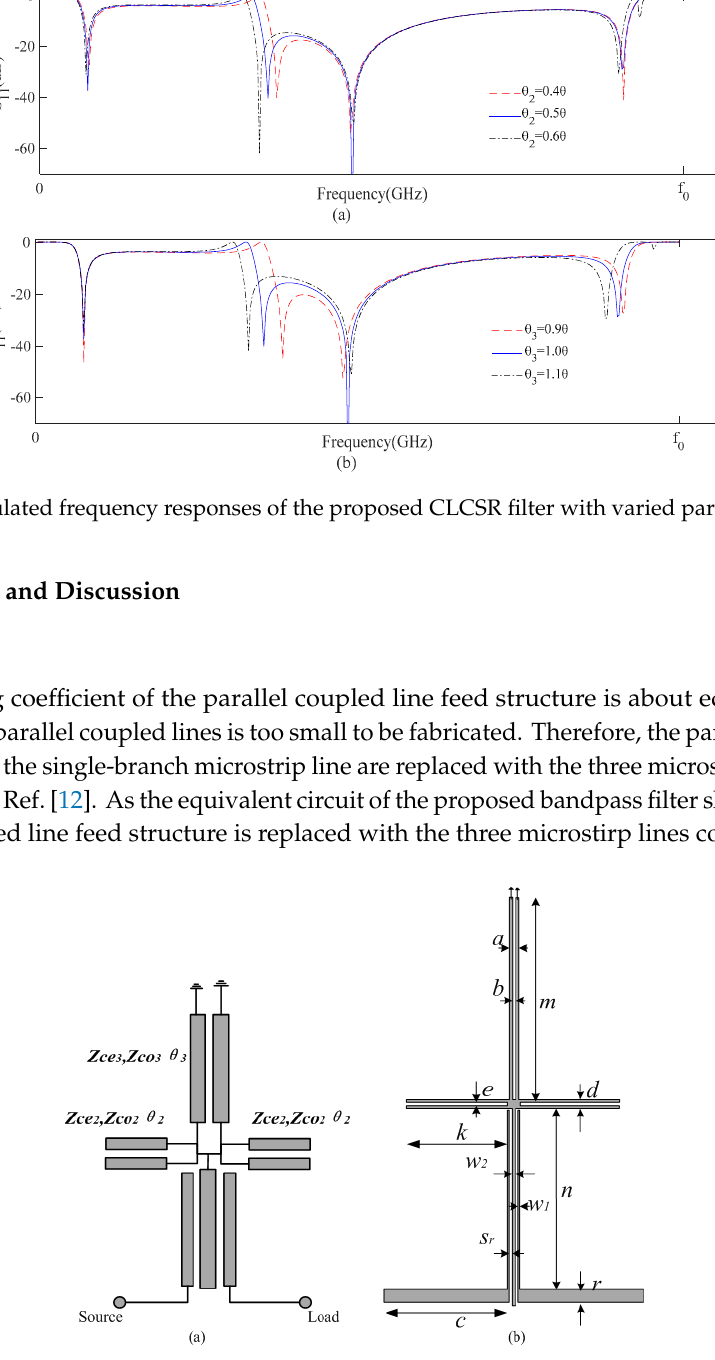
Figure 7. ( a ) The equivalent circuit of the proposed bandpass filter; ( b ) The design size of the proposed bandpass filter.